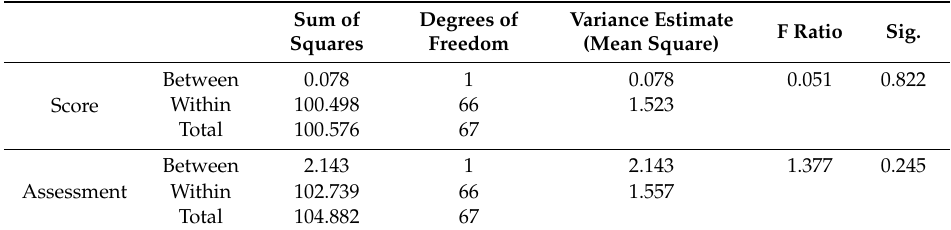
Table 4. Results of the ANOVA analysis for testing the significance of academic year.